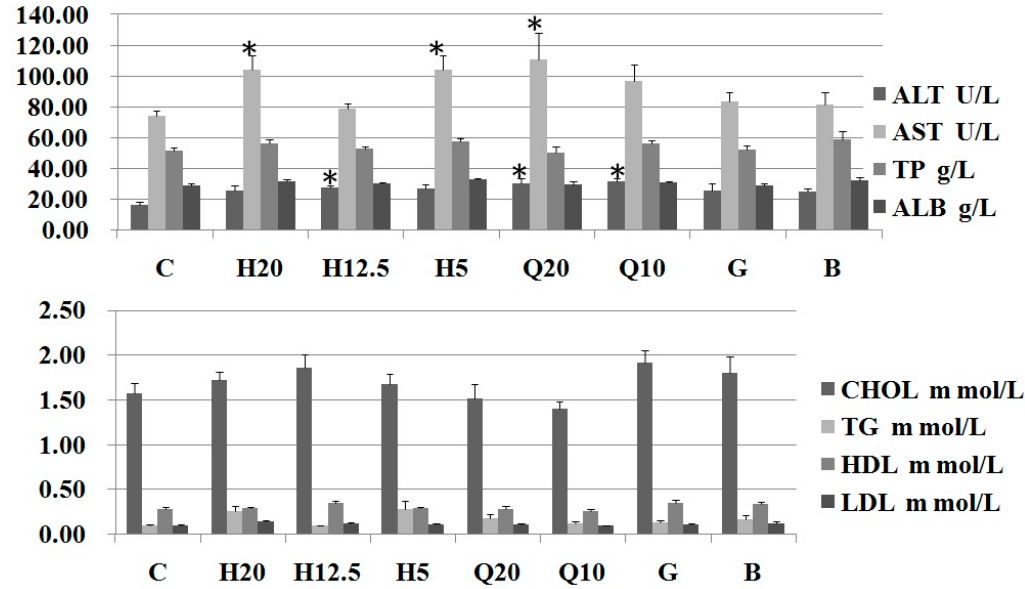
Figure 4. Effects on the liver function and blood lipid parameters in rats ( n = 8) of PS H and PF saponin extract; C: Control(0.2% CMC-Na solution); H: PS H(H20, 20 mg/kg; H12.5, 12.5 mg/kg; H5, 5 mg/kg); Q: